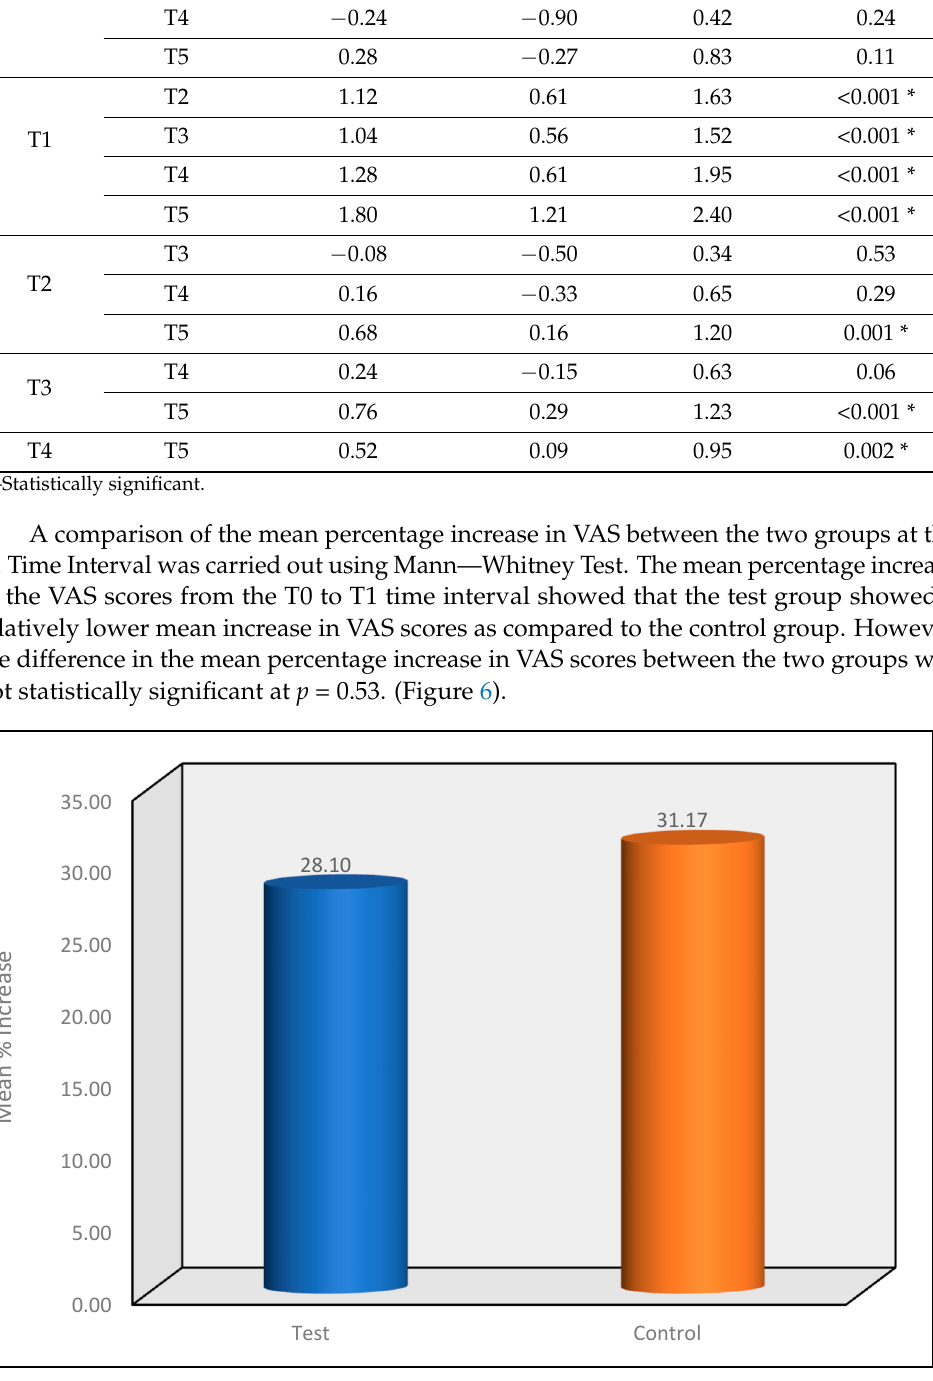
Table 5. Multiple comparison of mean difference in VAS scores b/w time intervals in the control group using the Wilcoxon signed-rank post hoc test.